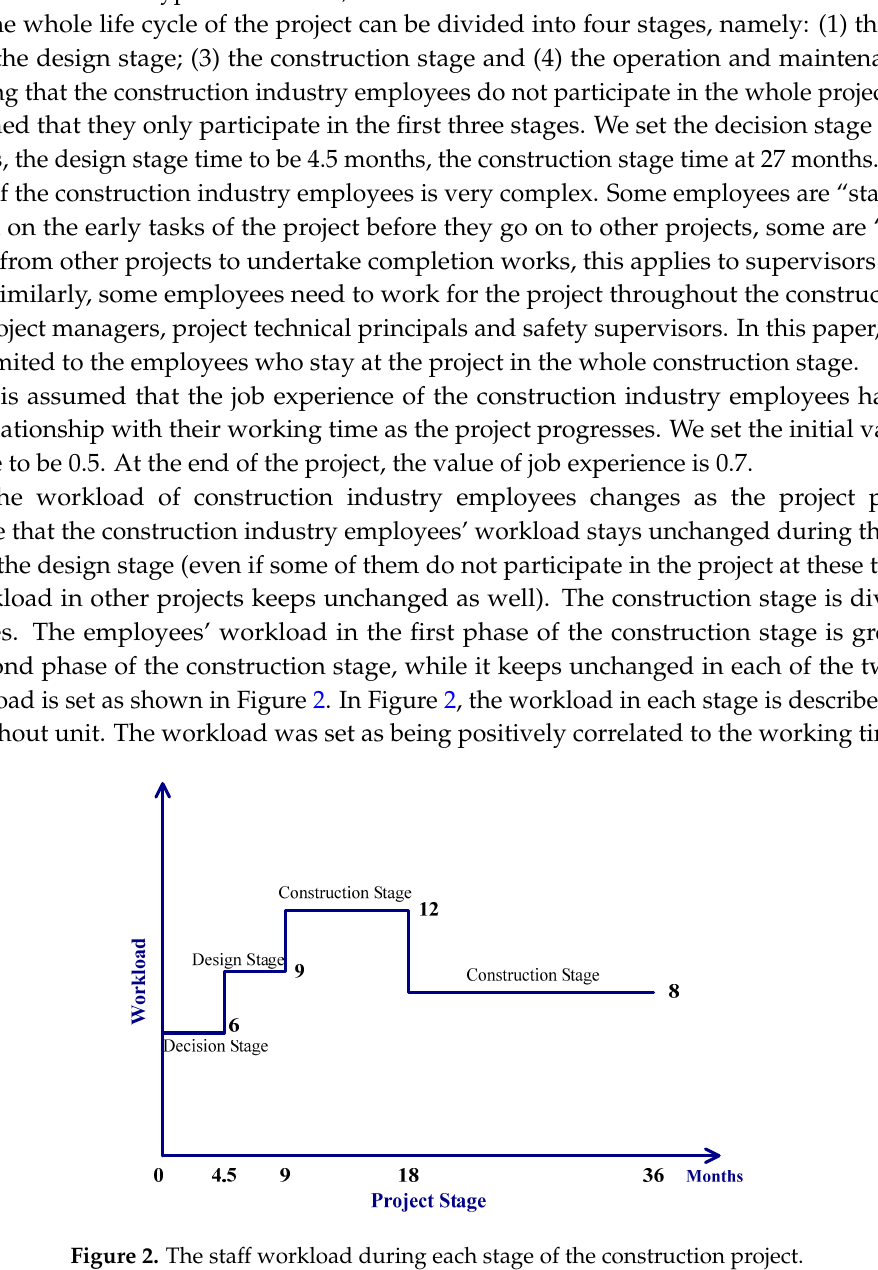
Figure 2. The staff workload during each stage of the construction